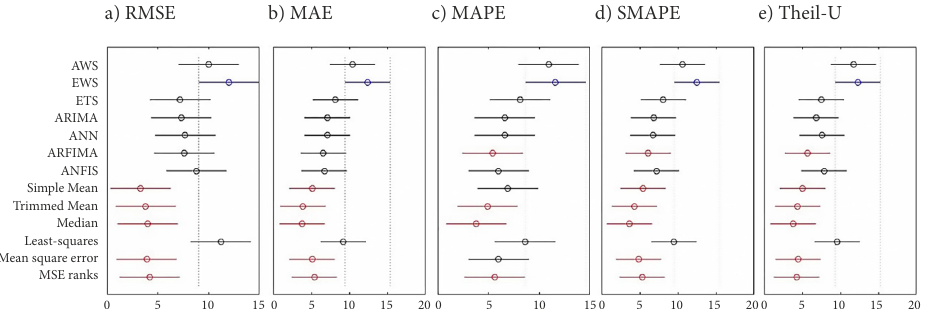
Fig. 4. Results of the multiple-comparison procedures in terms of RMSE, MAE, MAPE, sMAPE, and Theil’s